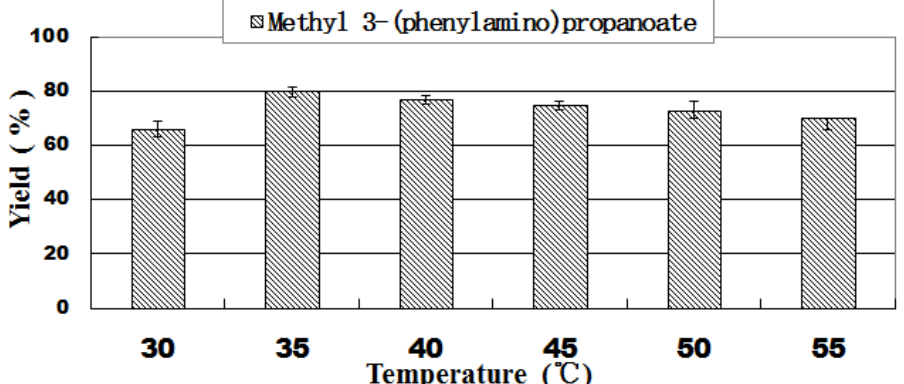
Figure 2. The effect of reaction temperature on enzymatic synthesis of β-amino acid esters in continuous-flow microreactors.